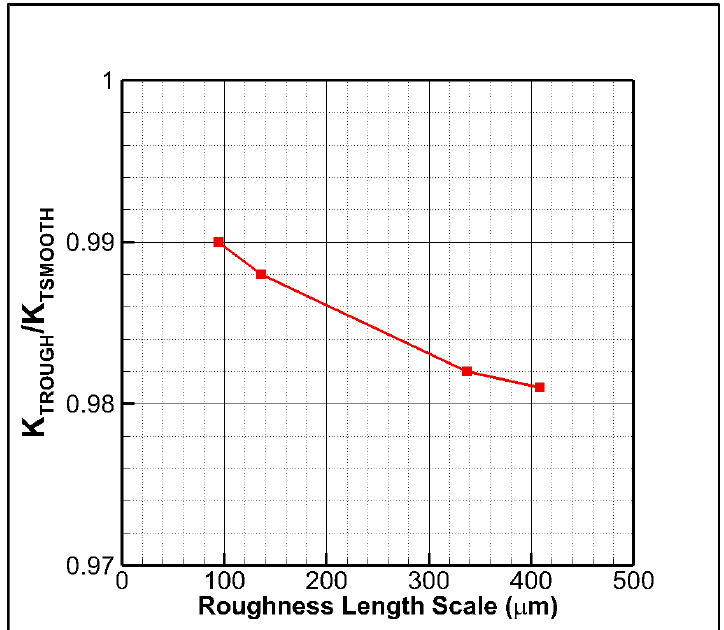
Figure 5. Change in thrust coefficient ( 𝐾 (cid:3021) ) with roughness. The change in torque coefficient (i.e., 10𝐾 (cid:3018) ) with roughness is also shown in Figure 6. Similar to thrust coefficient, roughness applied on the hub has a degradation effect on the torque coefficient of the propeller. The maximum reduction is found to be approxi- mately 1.5% at the maximum roughened condition.